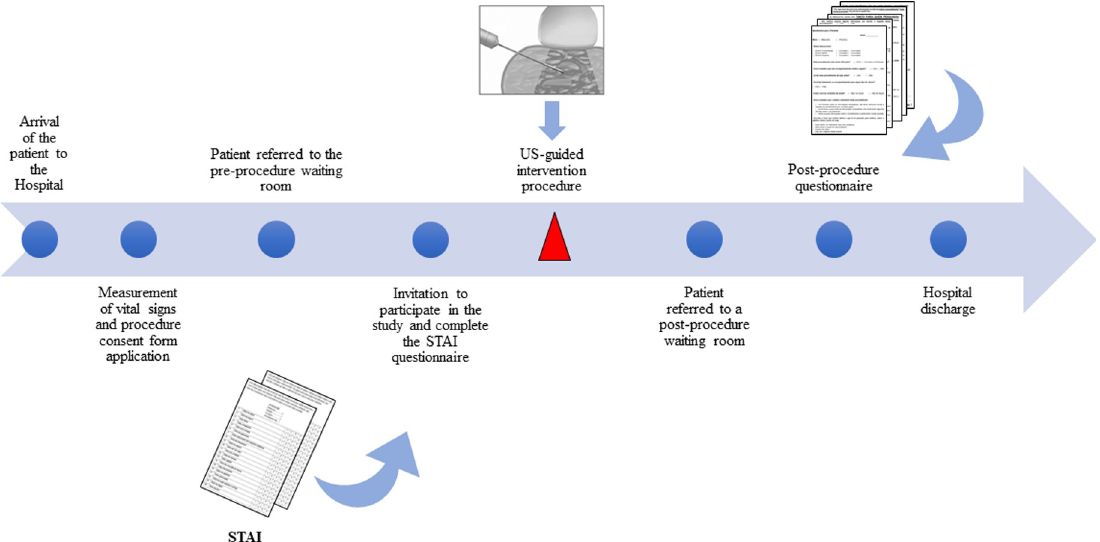
Fig 2. Flowchart representing the steps taken from the patients’ arrival at the hospital to the presentation of the questionnaires and the performance of the procedures. STAI, State -Trait Anxiety Inventory; US, ultrasound.